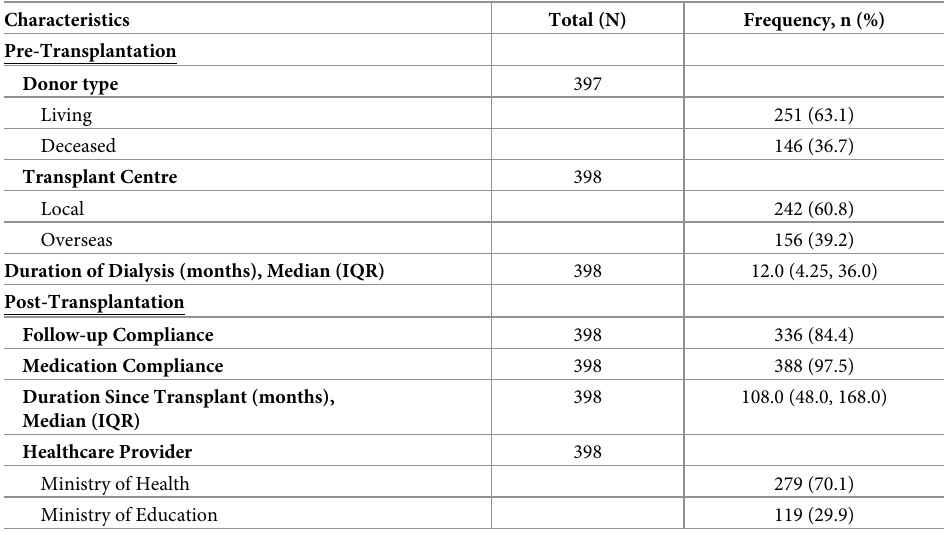
Table 2. Medical characteristics of kidney transplant recipients by household